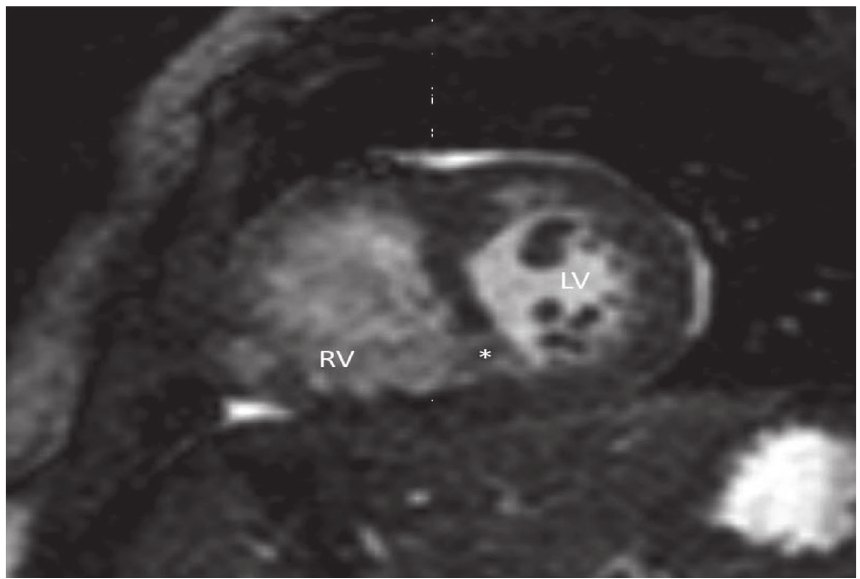
Figure 3: Short axis cine SSFP image of hypoplastic RV, VSD ( ∗ ) and normal sized LV. Note the abnormal trabeculations along the lateral and apical LV walls.